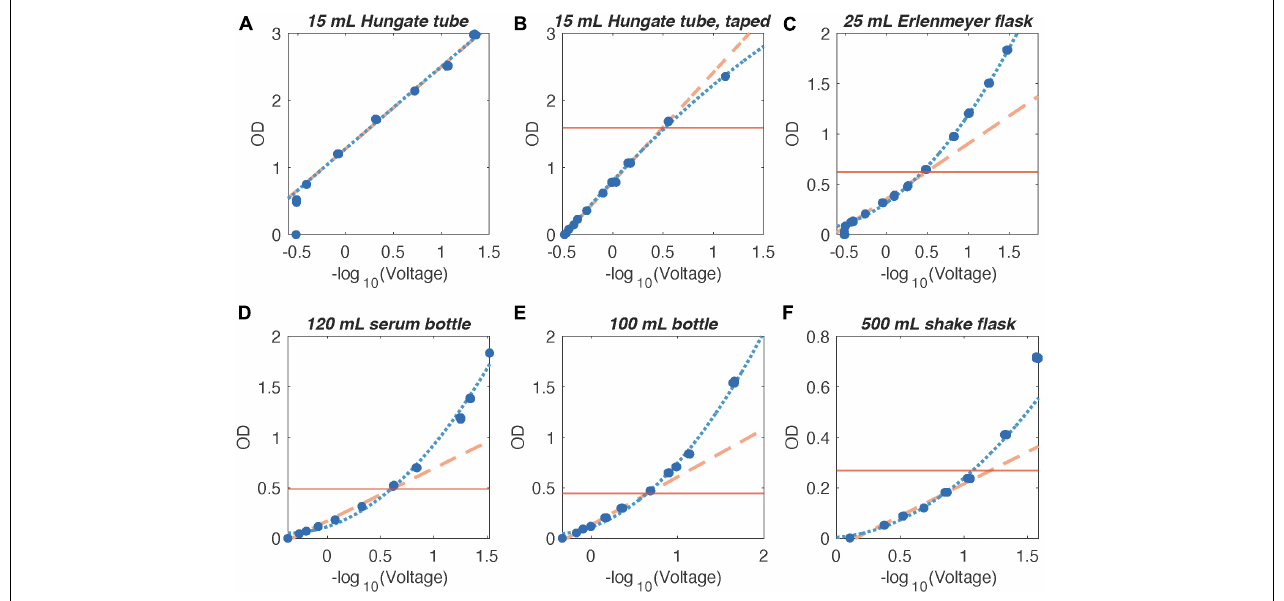
FIGURE 3 | Correlation of OD values measured by the commercial cuvette spectrophotometer at a wavelength of 600 nm and log 10 transformed ClampOD output voltage for fixed E. coli cell suspensions in various growth vessels. Dashed yellow lines: extrapolated linear fits to the linear portion of the correlation where ClampOD is equivalently accurate as the bench-top photometer; blue dotted lines: second order polynomial fit to data points within the extended detection range. The horizontal red lines indicate the OD · length = 2.5 threshold indicating the accuracy limit of the OD meters and coincides well with the OD at which the two fits diverge significantly. (A) Hungate tube, path length = 1.57 cm, (B) Hungate tube with tape, path length = 1.57 cm, (C) 25 mL Erlenmeyer flask, path length = 4.02 cm, (D) 120 ml serum vial, path length = 5.13 cm, (E) 100 mL bottle, path length = 5.62 cm, and (F) 500 mL baffled shake flask, path length = 9.33